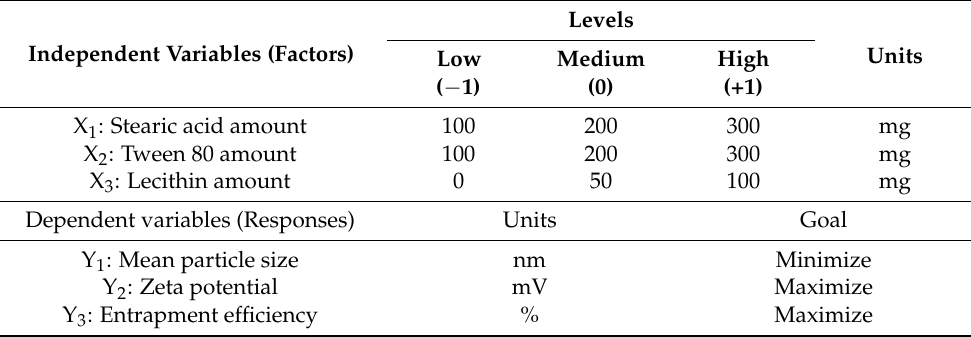
Table 1. Independent and dependent variables of Box–Behnken design for the development of Apx-loaded NLC